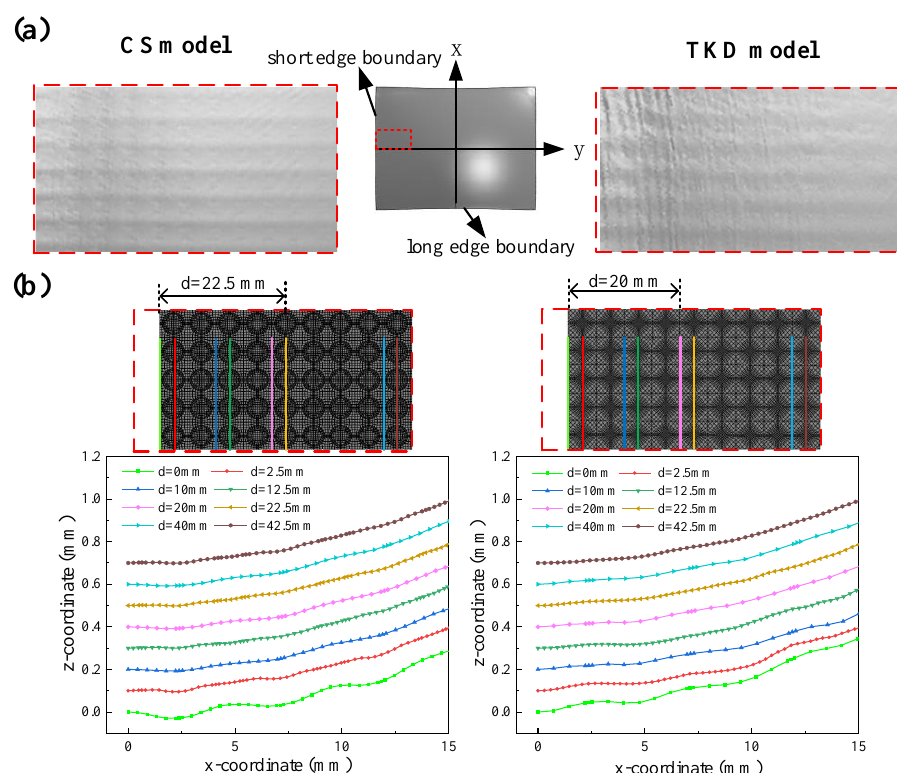
Figure 5. ( a ) Illumination maps of upper face sheet of spherical AFSP ( b ) Profile lines of upper face sheet of spherical AFSP.